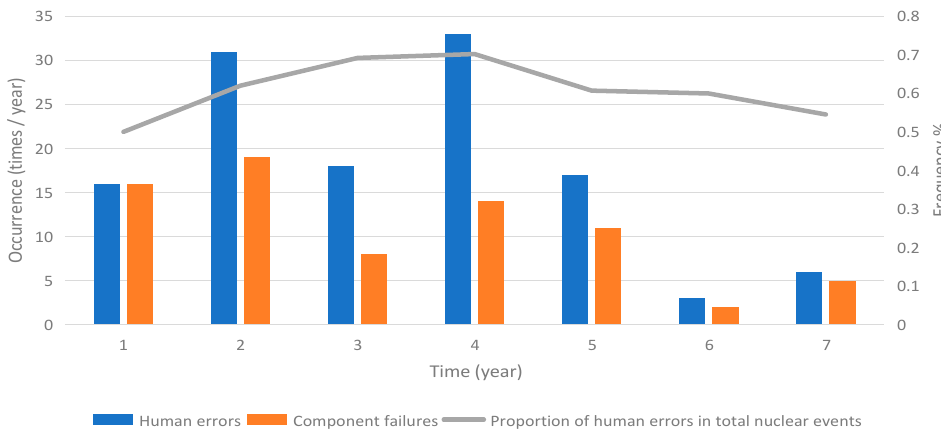
Figure 1. Statistics of incidents in the first seven years of China’s new NPPs.